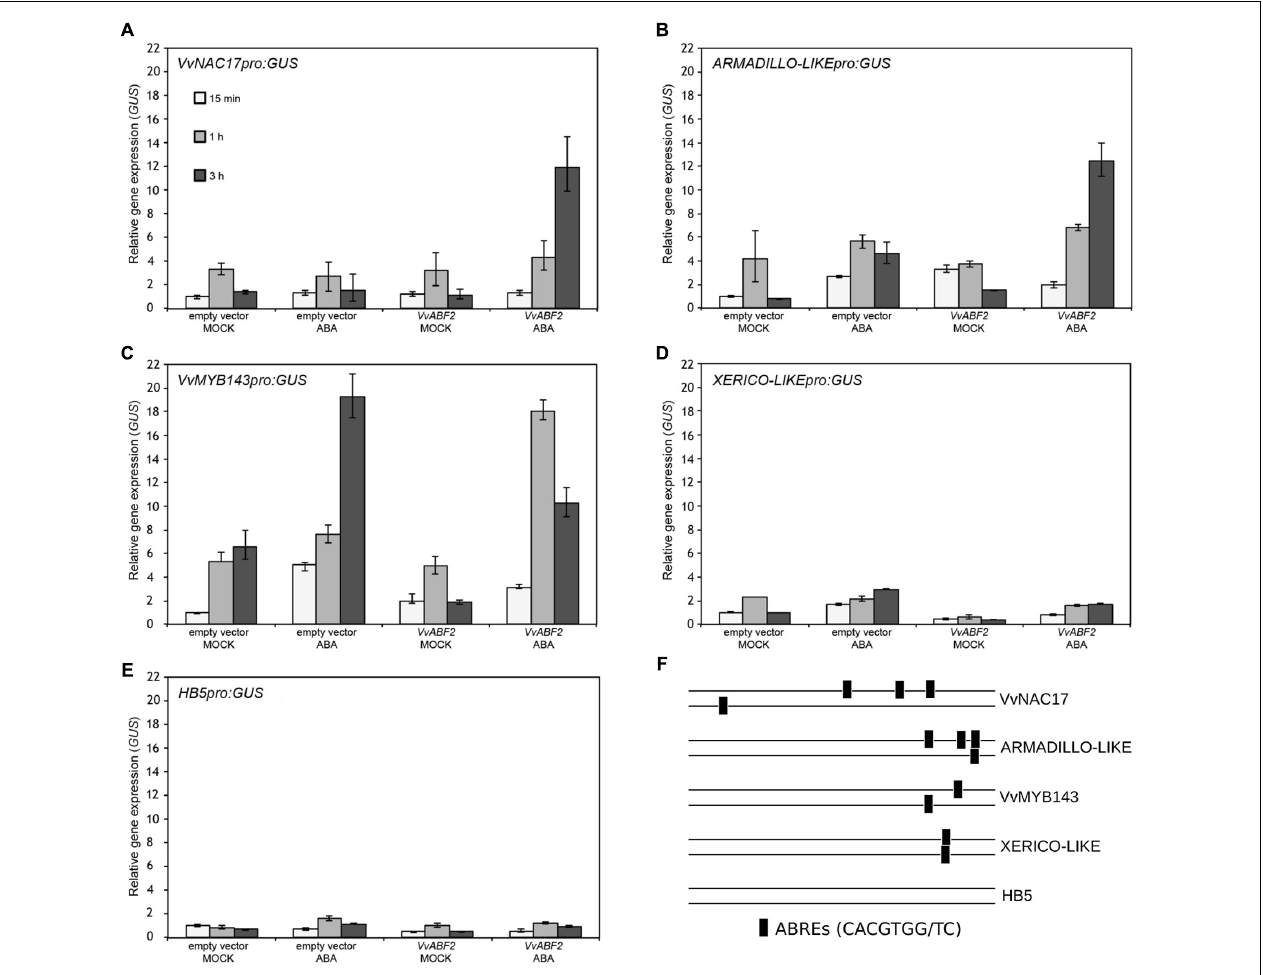
FIGURE 7 | Agrobacterium -mediated transient trans -activation assay in N. benthamiana . qPCR analysis of GUS expression in leaves of N. benthamiana co-transfected with the activating construct CaMV35Spro:VvABF2 and the following target constructs: (A) VvNAC17pro:GUS, (B) ARMADILLO-likepro:GUS, (C) VvMYB143pro:GUS, (D) XERICO-likepro:GUS, (E) HB5pro:GUS. Leaves co-infiltrated with the pK7WG2 vector devoid of the VvABF2 gene (empty vector) were used as a negative control for the trans -activation assay. Forty-eight hours after the first infiltration, leaves were infiltrated with 50 µ M ABA or with a mock solution and samples were collected after 15 min, 1, and 3 h. Relative GUS expression was determined using GUS-specific primers and normalized to the expression of the tobacco EF-1 α gene. Data are means of four biological replicates ± SD. (F) Distribution of the ABRE motifs in the five 1 kb promoters